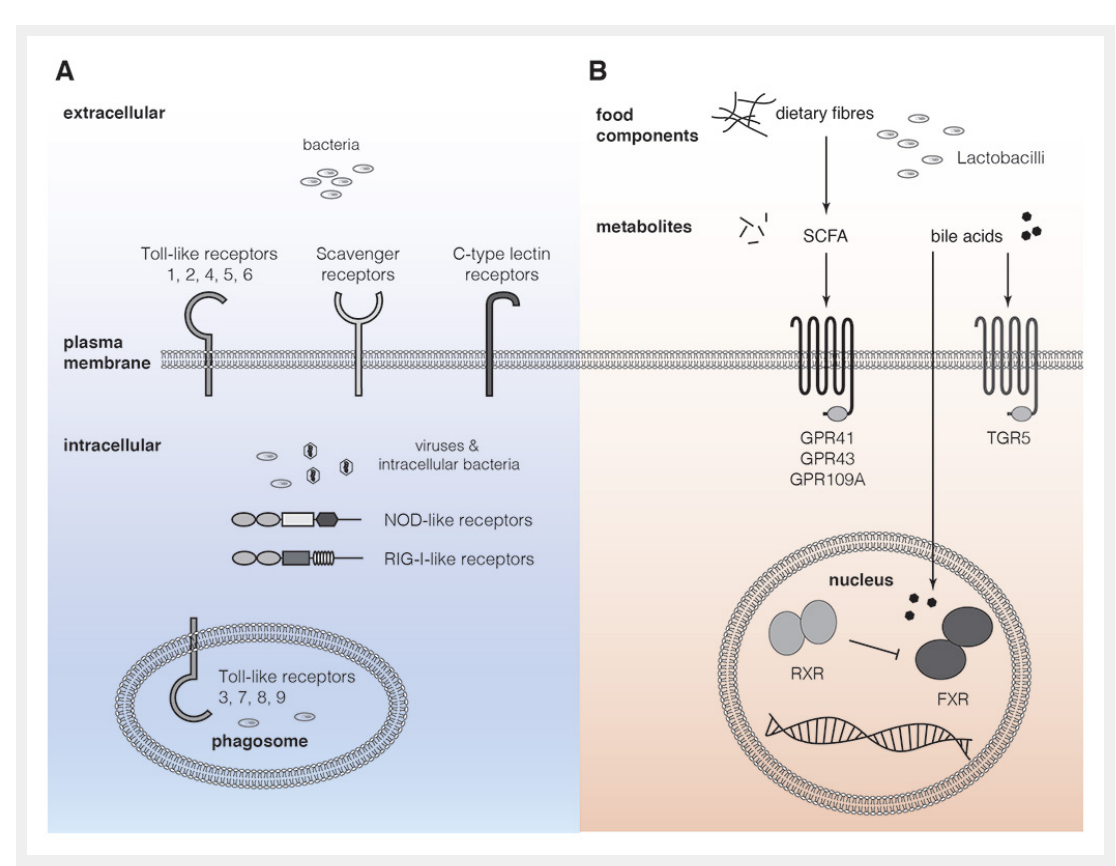
Not only conserved structural motifs of microorganisms, but also bacteria-derived metabolites are recognised by the host immune system. A. Pattern recognition receptors, such as Toll-like receptors, the scavenger receptors, the C type lectins, the RIG-I-like or the NOD-like receptors recognise pathogen-associated molecular patterns, which are highly conserved structural motifs or molecules common to microbes and viruses. B. Intestinal bacterial consortia metabolize food products and bile acids to short chain fatty acids (SCFA), secondary bile acids or vitamins. The G protein coupled receptor (GPR) recognizes SCFA, the intracellular farnesoid X receptor (FXR) and the transmembrane G coupled receptor 5 (TGR5) sense secondary bile acids and retinoic acid is recognized by the retinoid X receptor to modulate host